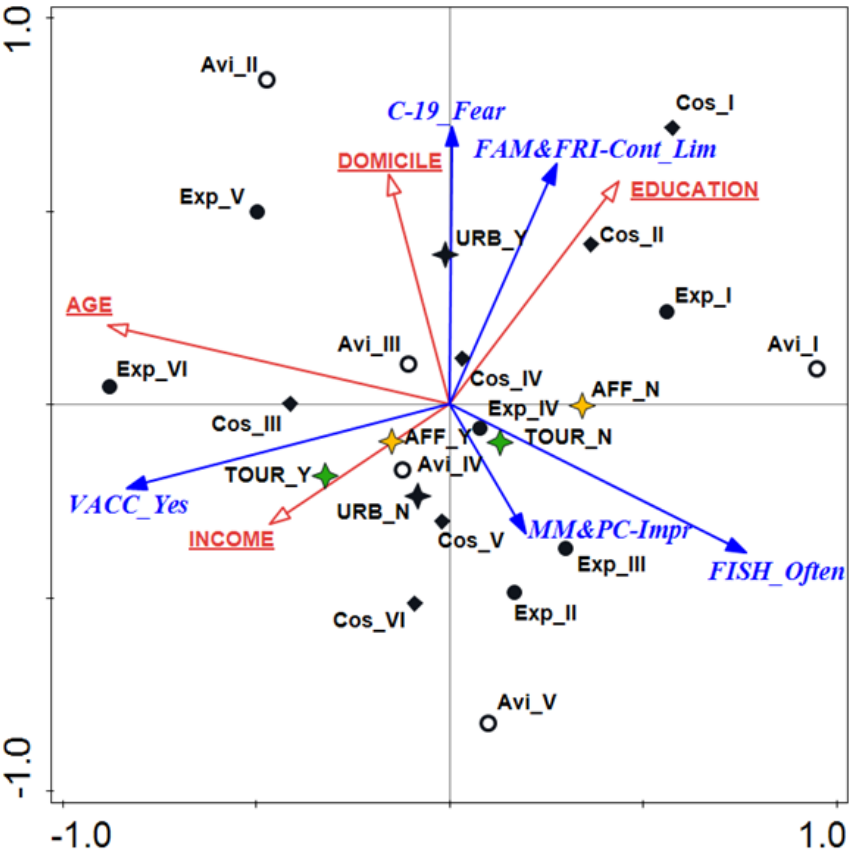
Figure 2. Triplot ordinal redundancy analysis (RDA) of reactions and behavior among anglers feeling positive effects of fishing on COVID-19 pandemic stress reduction (response data-blue arrows) versus socio-demographic factors (explanatory variables-red arrows). Abbreviations: VACC_Yes, positive attitude toward vaccination against COVID-19; C-19_Fear, feeling afraid of getting sick from COVID-19; FAM&FRI-Cont_Lim, limiting social contact with family and friends; FISH_Often, fishing more often during the pandemic; MM&PC_Impr, feeling of improvement in mental and physical conditions. For the anglers’ groups of preference and engagement abbreviations, see Table S2 (black circle-Experience categories; white circle-Avidity categories; black diamond-Cost categories; green star—two categories based on responses to the question “Fishing is the main tourism motive”, including positive-TOUR_Y and negative-TOUR_N; yellow star-two categories based on responses to the question “Affiliation in angling association”, including positive-AFF_Y and negative-AFF_N; black star-two categories based on responses to the question “Most visited angling spot is in the urban area”, including positive-URB_Y and